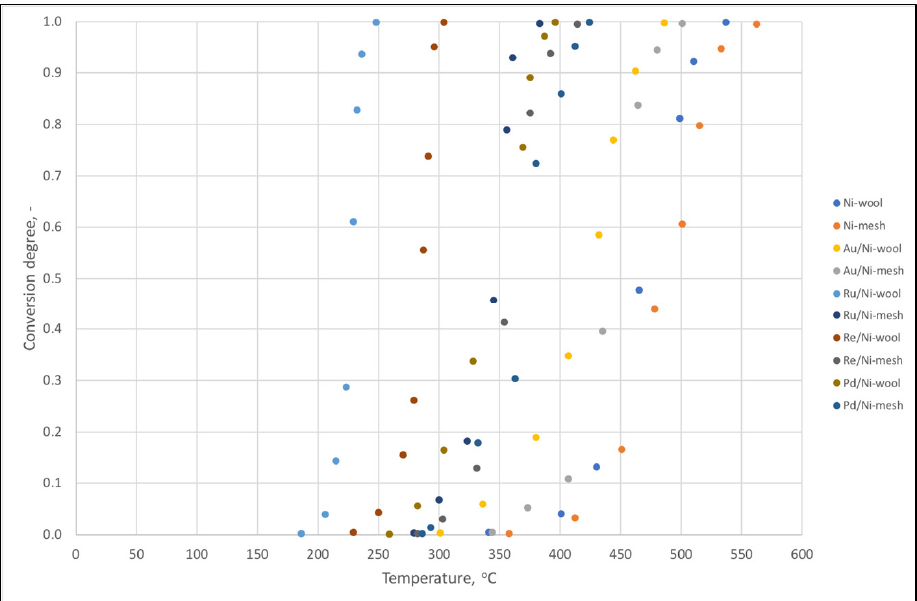
Figure 6. CO 2 conversion of catalysts made of nickel wool or nickel mesh and ornamented with ca. 1% nano-Ru, -Re, -Pd, or -Au.